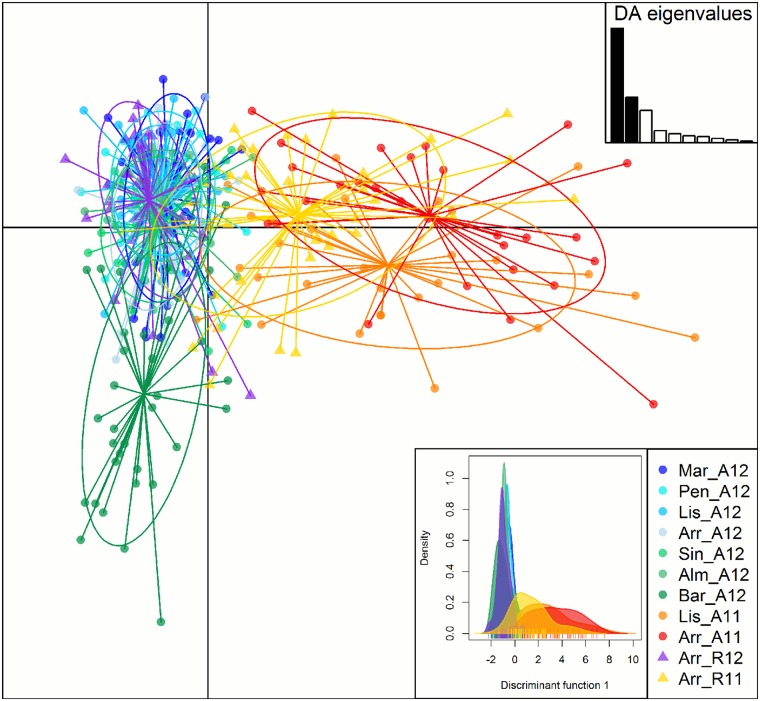
Scatterplot of the DAPC.Individual adult genotypes are represented in dots and recruit genotypes in triangles. Populations are distinguished by colors and 95% inertia ellipses. Barplot of DA eigenvalues (bottom right) displays the proportion of genetic information comprised in each consecutive discriminant function. X and Y axis of the scatterplot describe the first and second discriminant function (explaining 81.8% and 31.6% of genetic variance, respectively). Left from the legend is a density plot of the genetic information from only the first discriminant function.